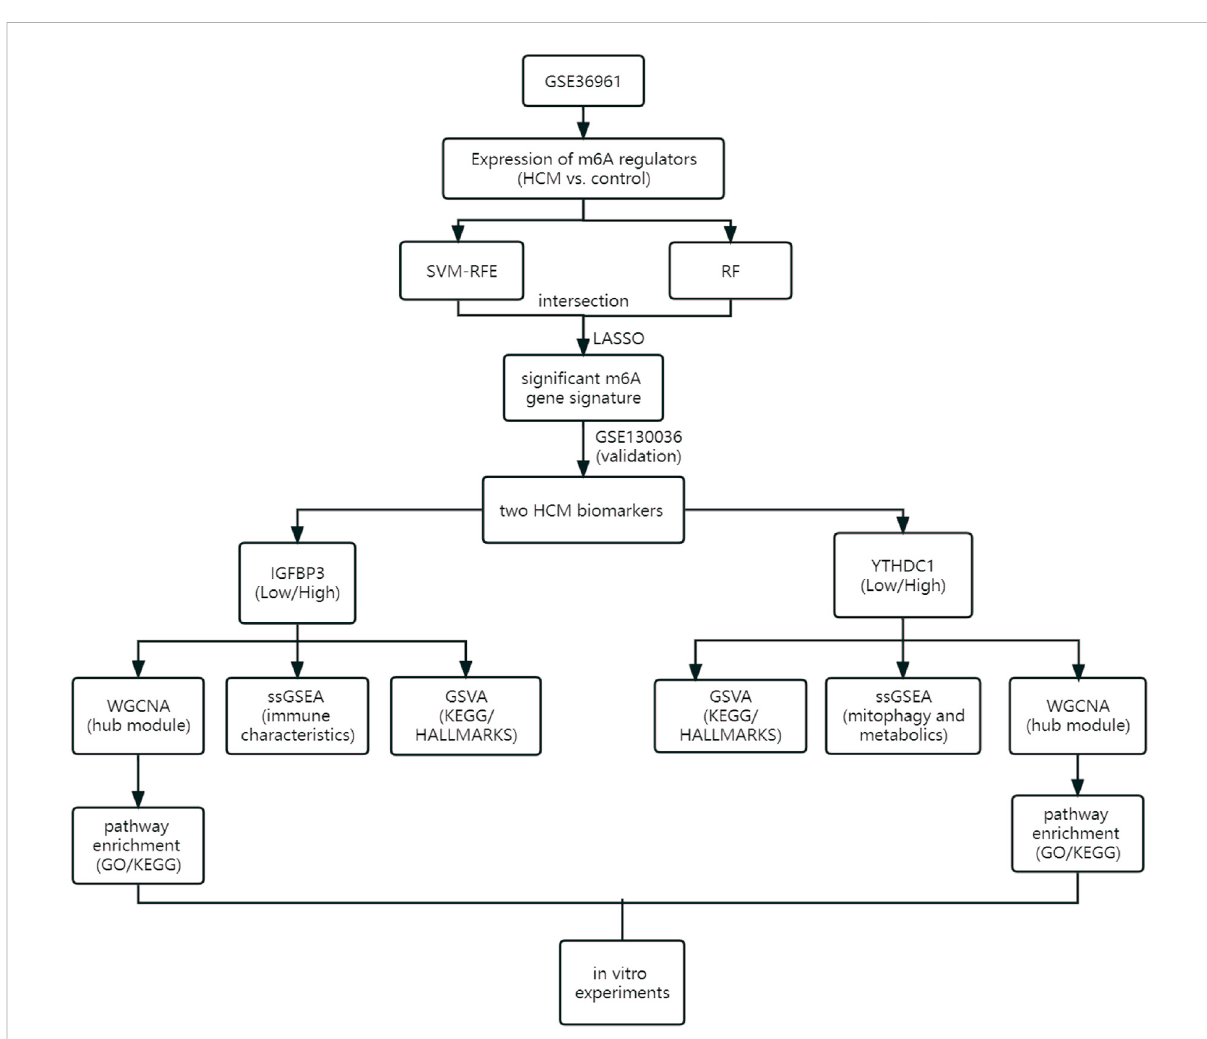
FIGURE 1 Study fl ow diagram.GO, GeneOntology; GSVA, gene set variation analysis; HCM, hypertrophic cardiomyopathy; KEGG, Kyoto Encyclopedia of Genes and Genomes; LASSO, least absolute shrinkage and selection operator; RF, random forest; ssGSEA, single sample gene set